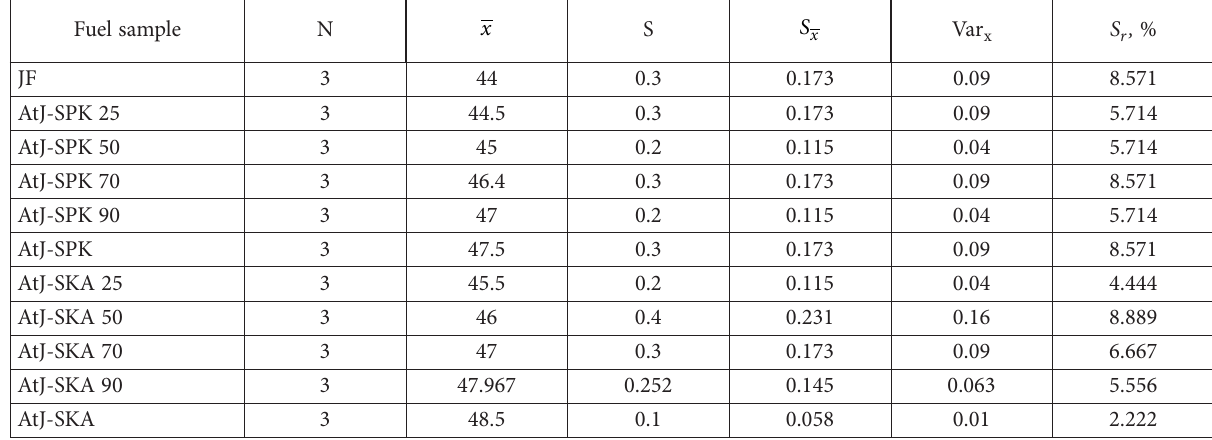
Table A4. Statistical error analysis of the flash point measurements (source: author development) Fuel